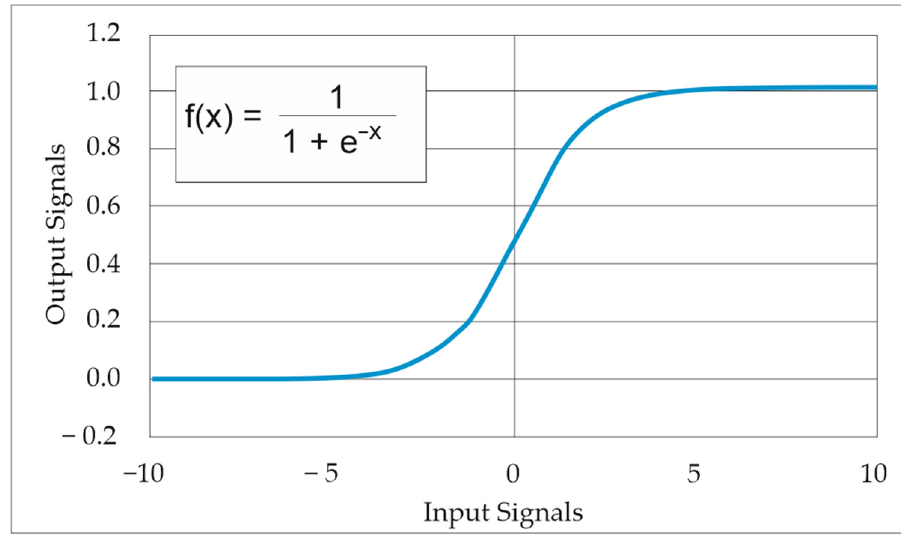
Figure 4. Sigmoid function for ANN.